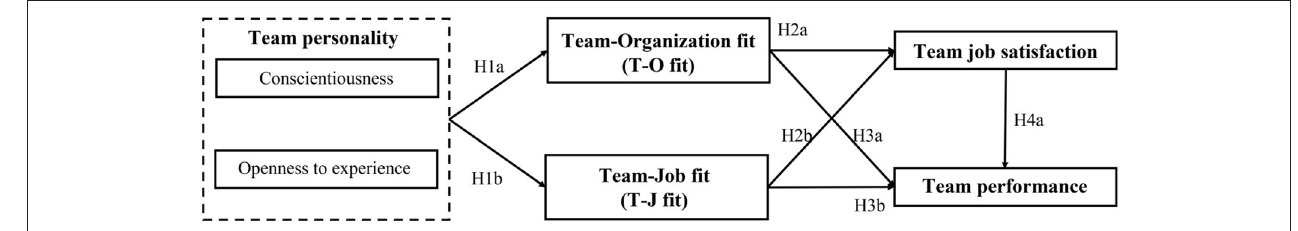
FIGURE 1 | Research